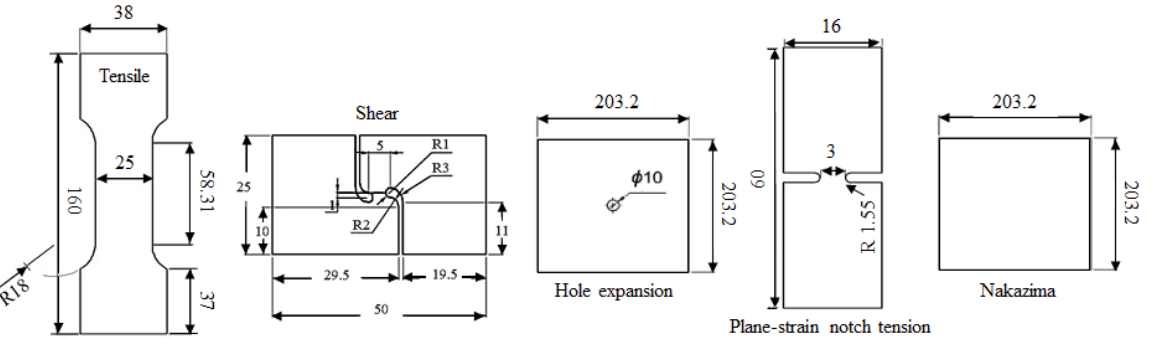
Figure 1. Specimen geometries for the tensile [31], shear [32], hole-expansion [33], plane-strain notch tension [34], and Nakazima [35] tests (note: dimensions are in millimeters).